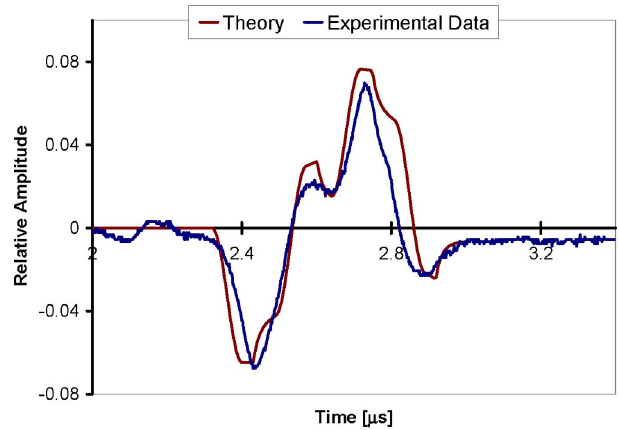
FIG. 24. (Color) Cold-fluid model versus measurement of the perturbation on the beam current waveform. Initial perturbation applied at t (cid:5) 0 . The beam energy is the only fitted parameter for the cold-fluid model. The upstream voltage pulse waveform and pulsed quadrupole length was input to the model